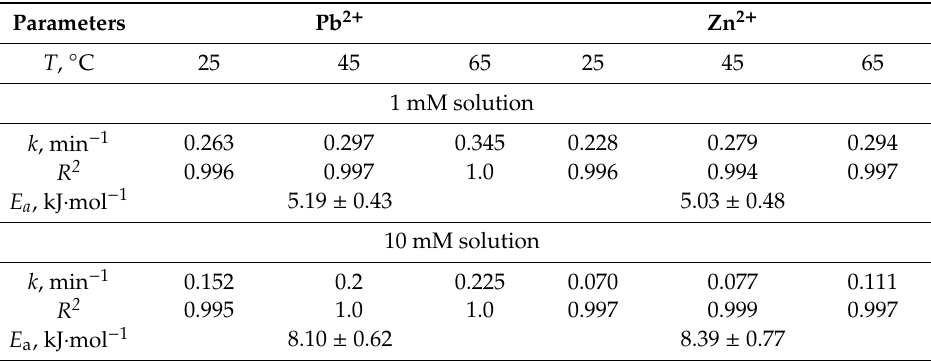
Table 3. Kinetic parameters of The film di ff usion model for Pb 2 + and Zn 2 + sorption at di ff erent temperatures and solute concentrations on titanium phosphate.